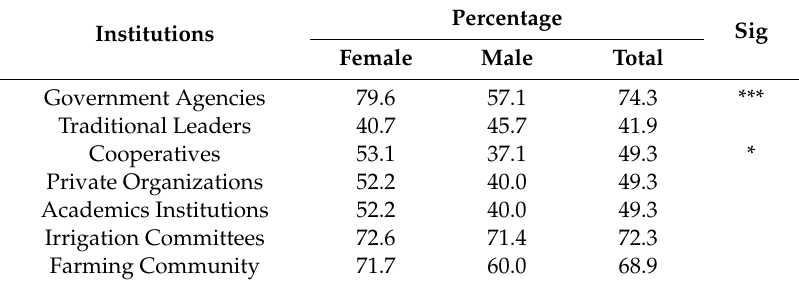
Table 3. Percentage of scheme farmers who benefit from institutions.